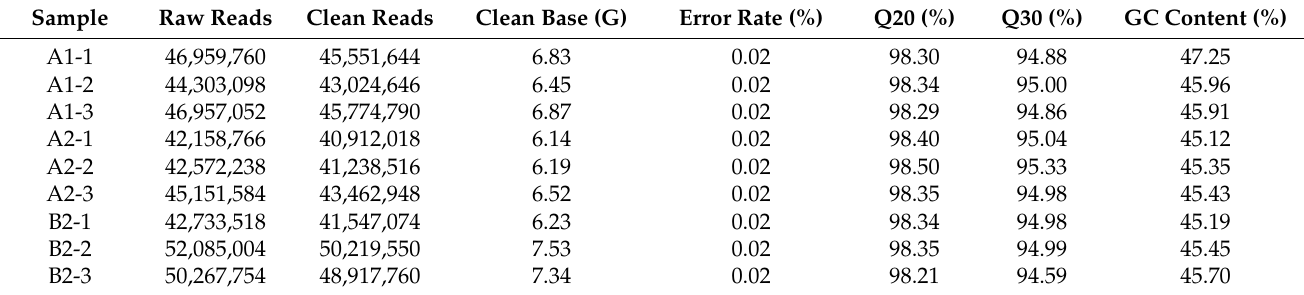
Table 2. Statistical results of transcriptome sequencing of ‘Feizixiao’ litchi pulp in 2020.